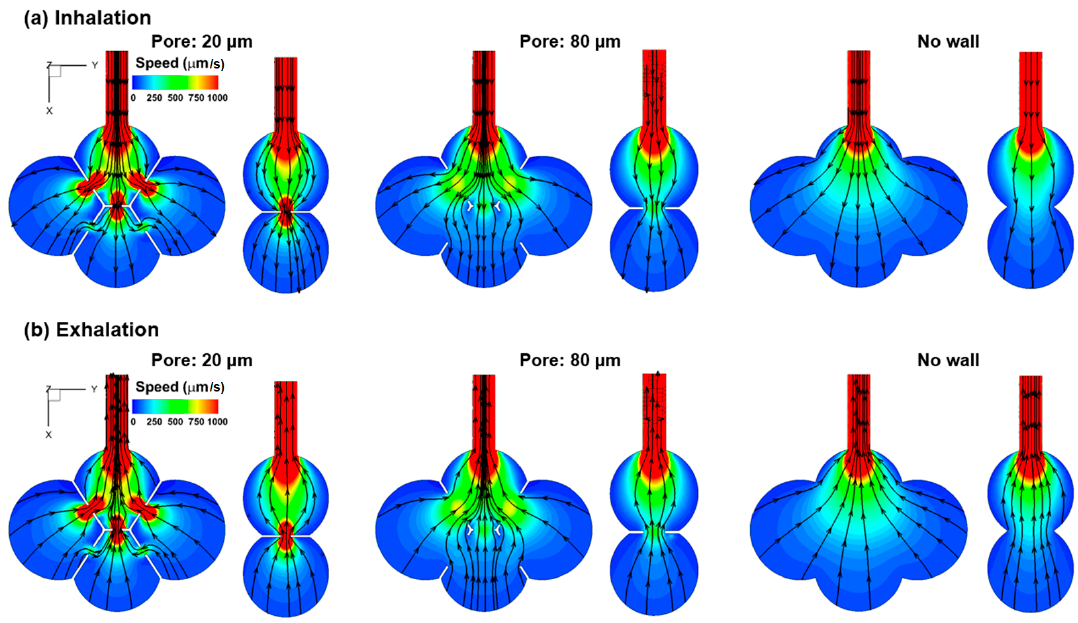
Figure 3. Contour and stream traces in the four-alveolar models with a pore size of 40 µm, 80 µm, and no septal wall during ( a ) inhalation, and ( b ) exhalation.